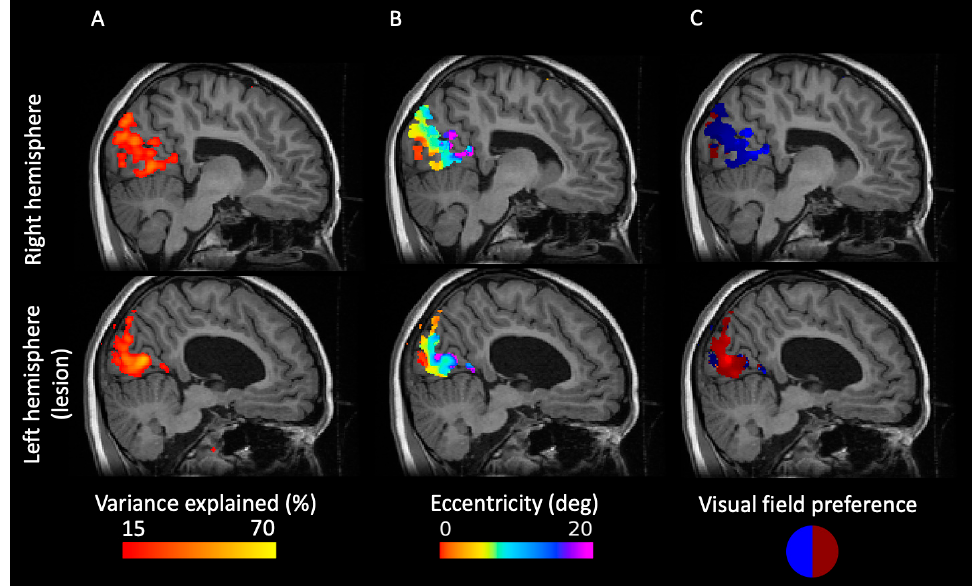
Figure 2. Visual cortex of patient IB is retinotopically organized. ( A ) Map of variance explained estimated from pRF mapping. The higher the value, the more confident the estimation of the pRF. ( B ) Eccentricity map shows an orderly representation of the visual field in both hemispheres. ( C ) Preference of visual field location along the x-axis. Each hemisphere processes the information from the contralateral visual field. All maps are masked with the variance-explained threshold of 15%.